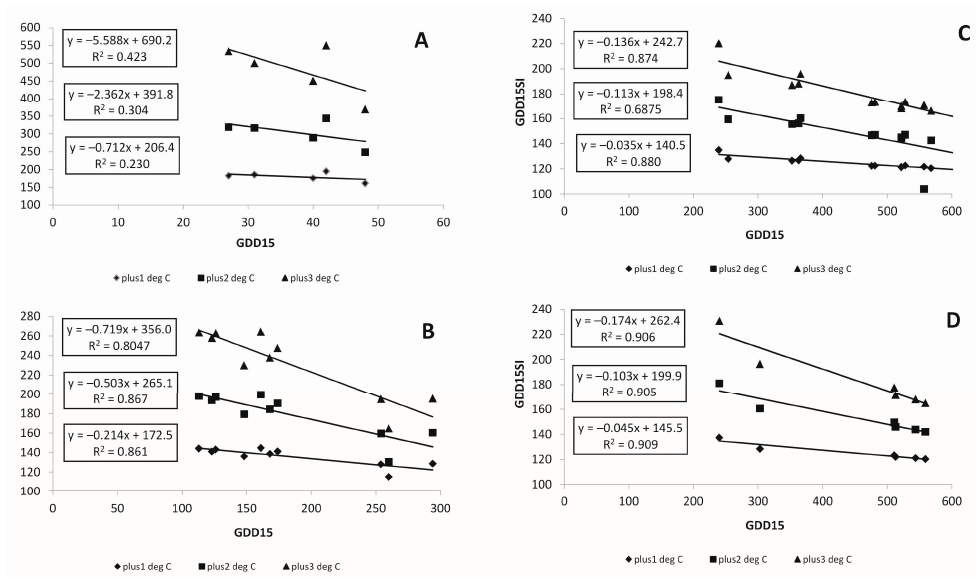
Figure 12. Relationship between growing degree days with 15 °C threshold (GDD15) and Sensitivity Index (GDD15SI) depending on its standard deviation (SD15) for locations in the Russian Far East for the period 1966–2017 for +1, +2 and +3 °C warming scenarios: ( A ) for SD15 near 25, ( B ) for SD15 near 55, ( C ) for SD15 near 75, ( D ) for SD15 near 85.